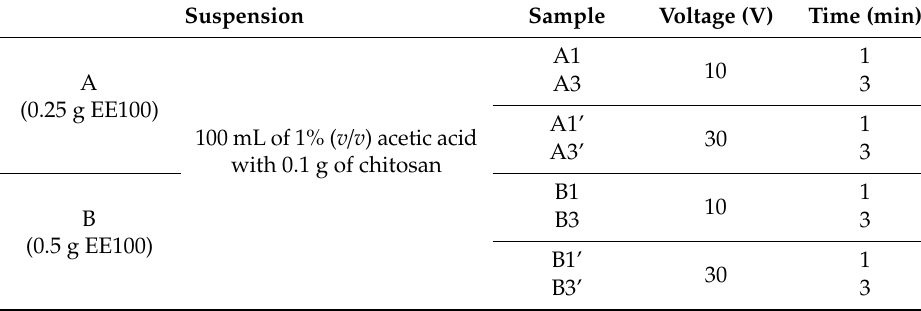
Table 2. Designations of experiment samples with the applied process